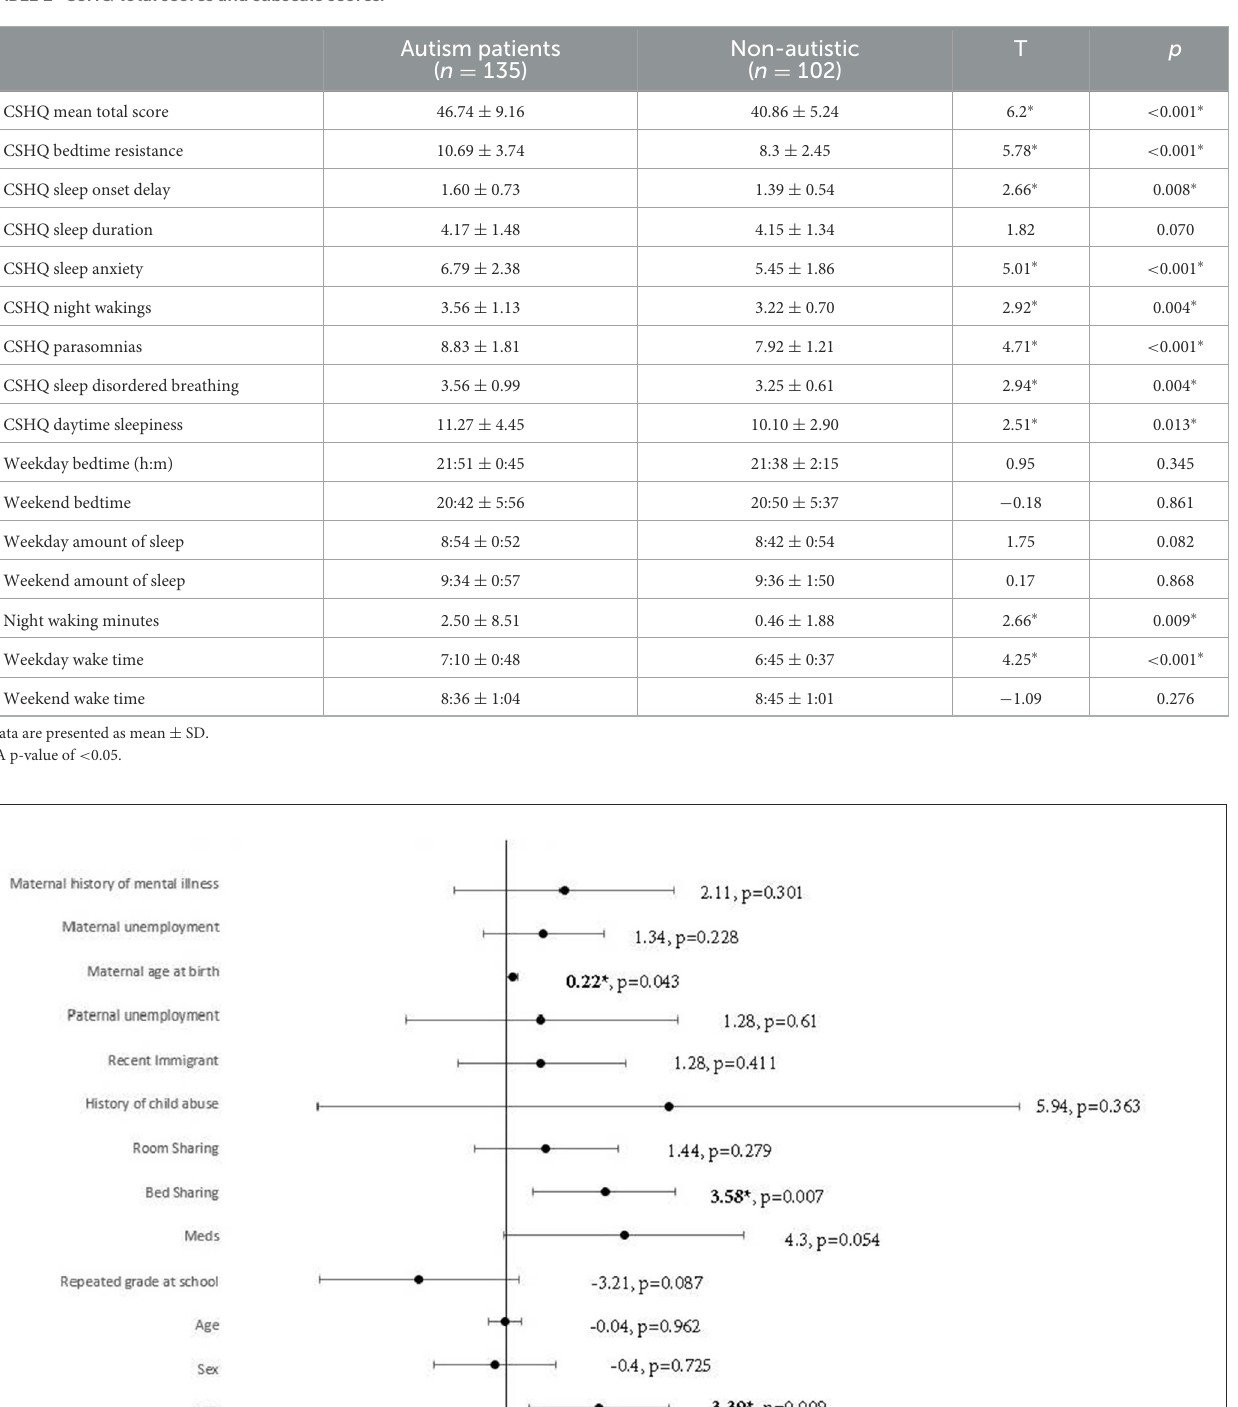
TABLE 2 CSHQ total scores and subscale scores.